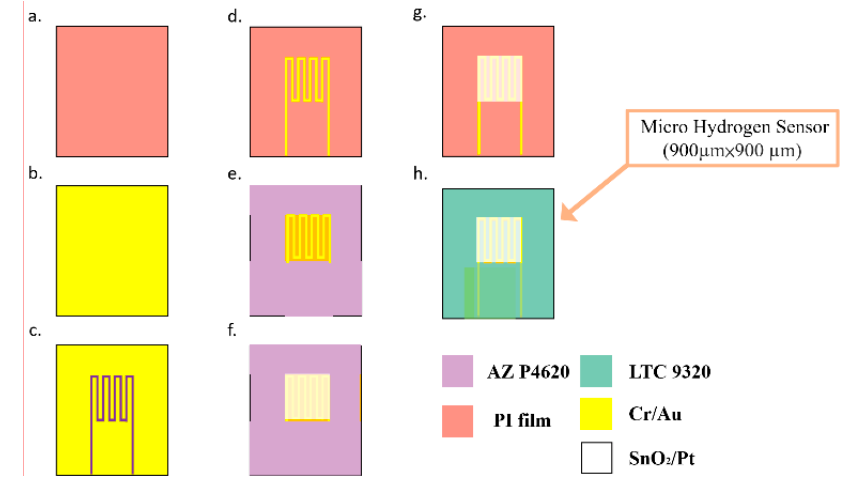
Figure 1. Process diagram of flexible micro hydrogen sensor. Figure 2. Process diagram of flexible micro hydrogen